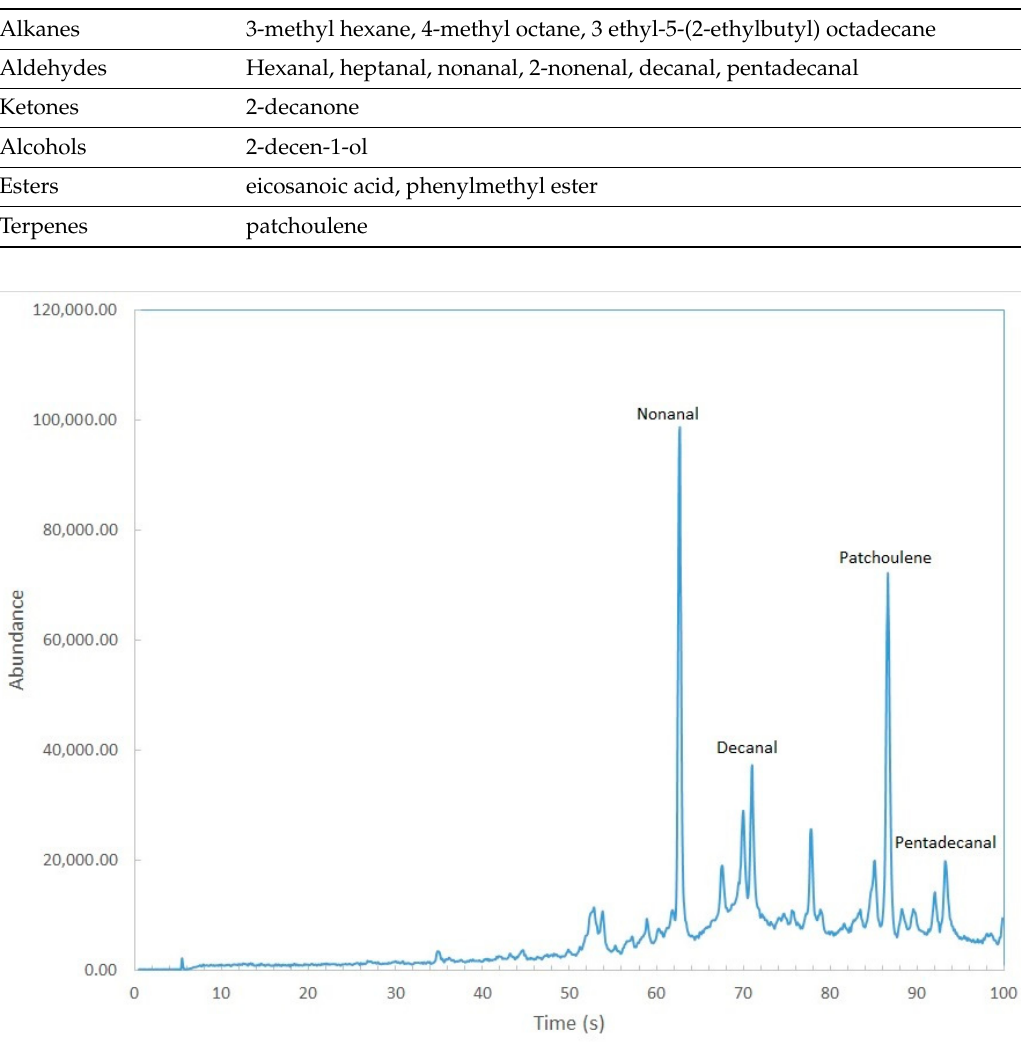
Table 2. Compounds commonly identified during malting.